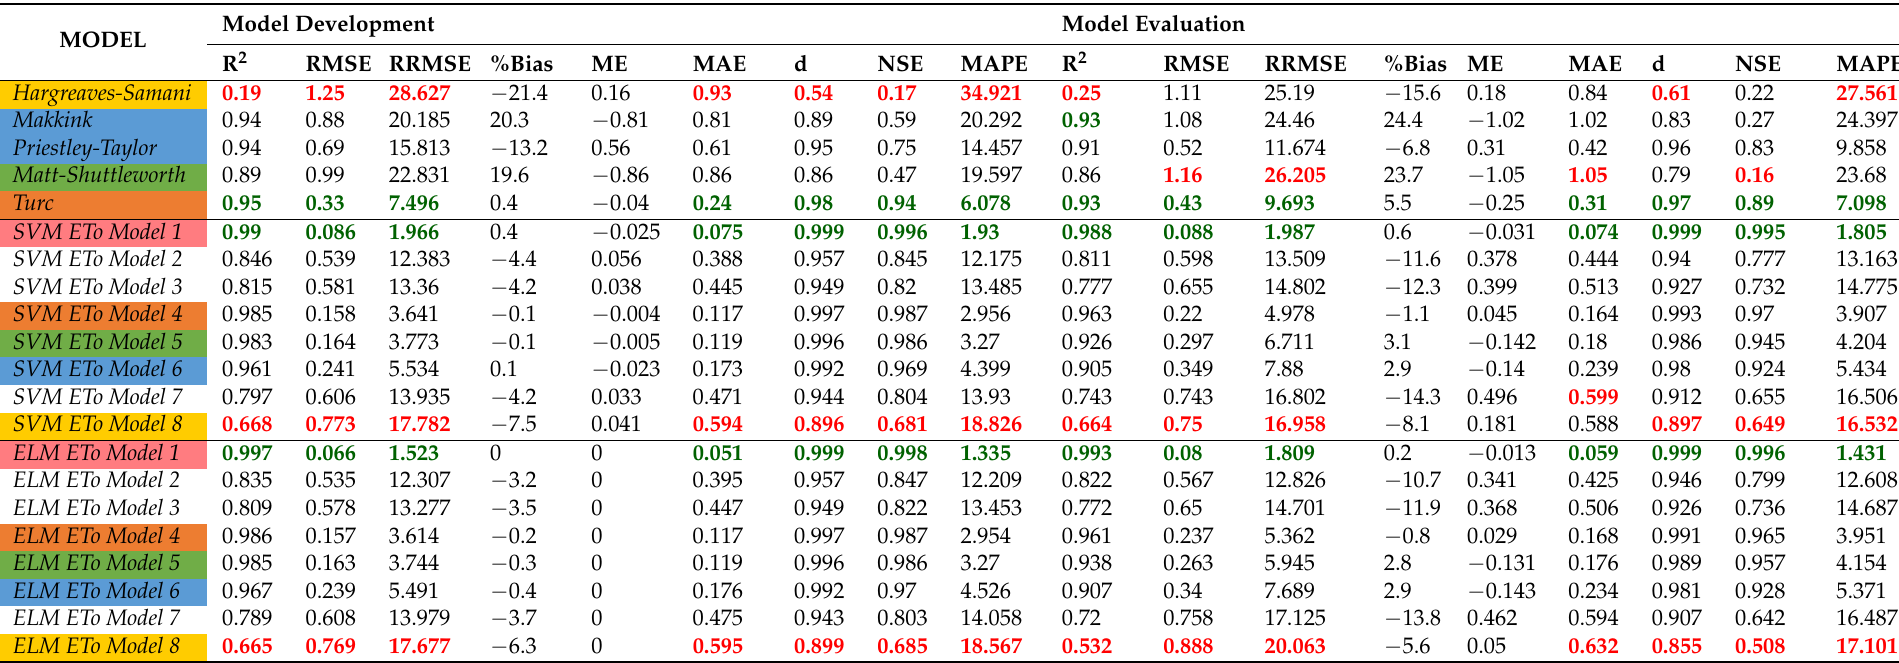
Table 6. Statistical values of empirical and machine learning models used for estimating daily ETo at Sangley Point Station